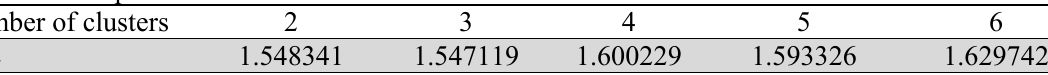
The number of parameters career clusters Number of clusters